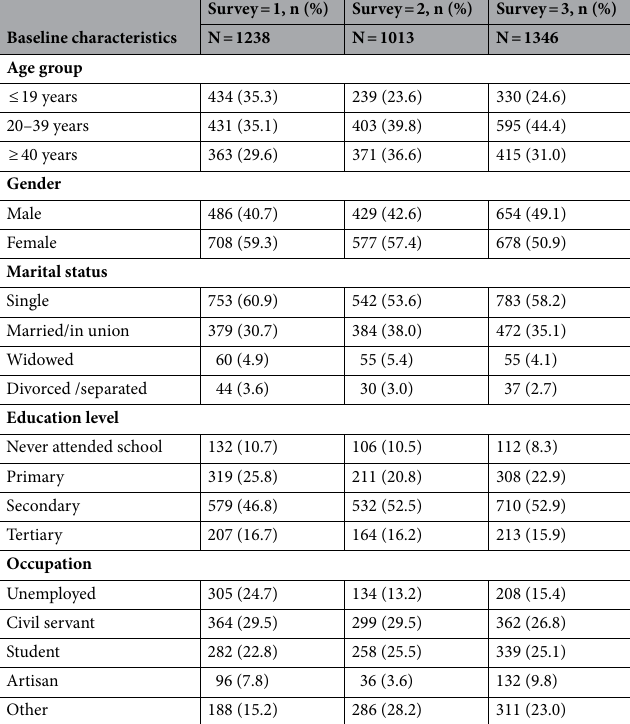
Table 1. Baseline characteristics of study participants enrolled.